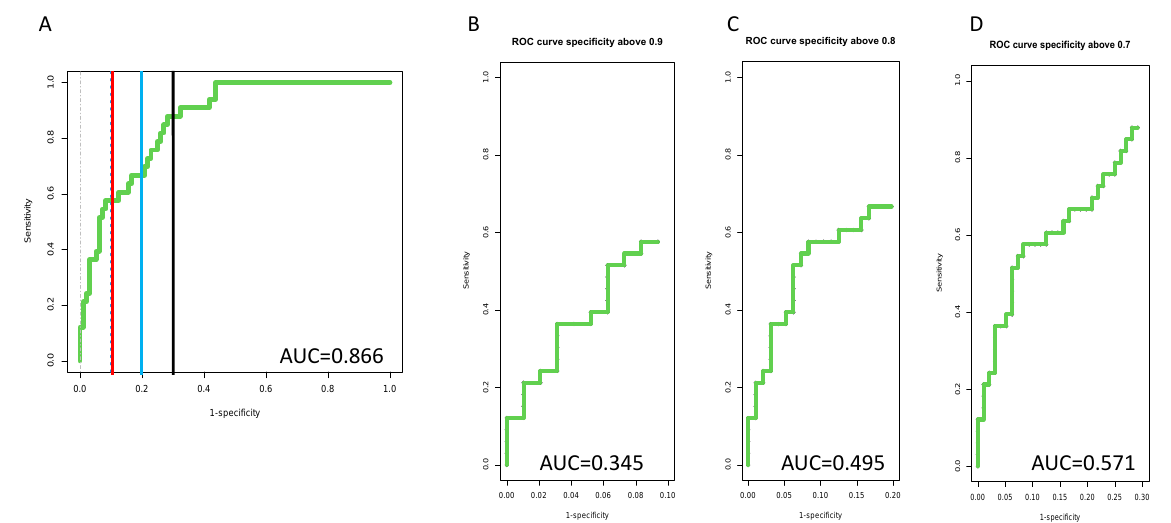
Figure 5. Diagnostic algorithm improves detection of early-stage HCC. ( A ) External validation of the diagnostic algorithm in all patients with early-stage HCC at any time prior to HCC detection. Panels ( B – D ) show the 90-ROC, 80-ROC and 70-ROC. In Panel A, the red line mark 90% specificity, the blue line mark 80% specificity and the black line mark 70% specificity.